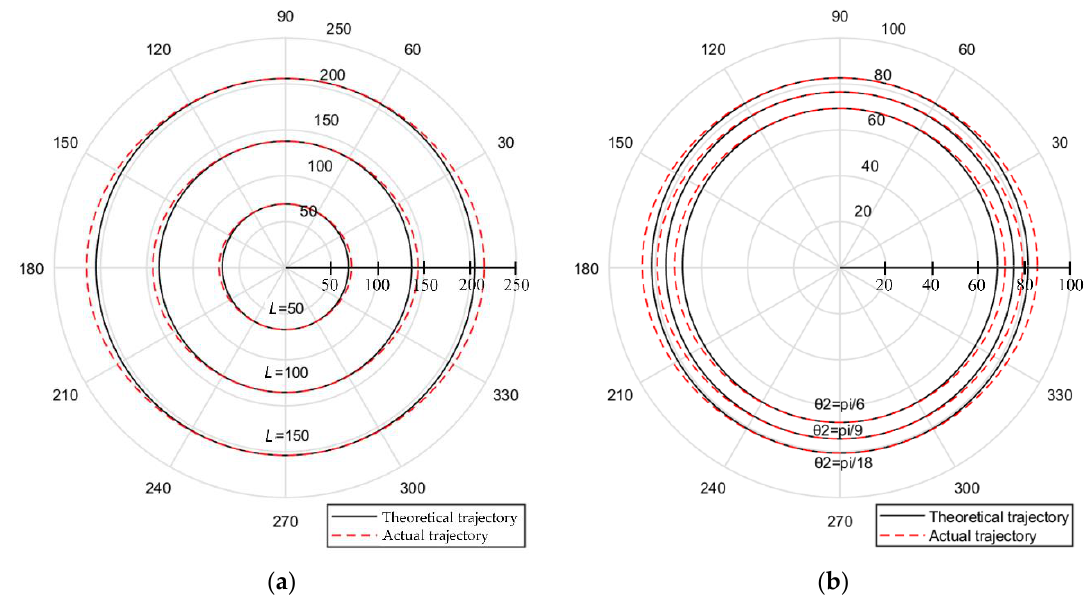
Figure 4. Simulation results of the influence of the first order uniform contraction of ball screw and linear grating on the circular motion trajectory of machine tool. ( a ) The result under different bar lengths. ( b ) The result under different pose angles.